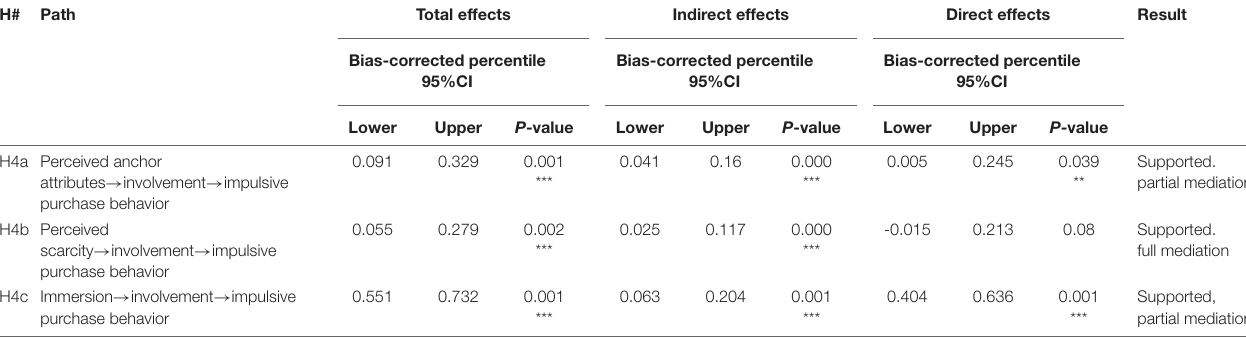
TABLE 7 | Results of mediating